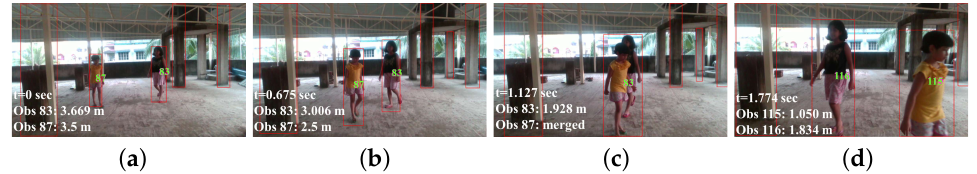
Figure 24. Performance of the proposed tracking algorithm with two moving obstacles along with multiple static obstacles. ( a – d ): Time-sampled snapshots with the results using our proposed